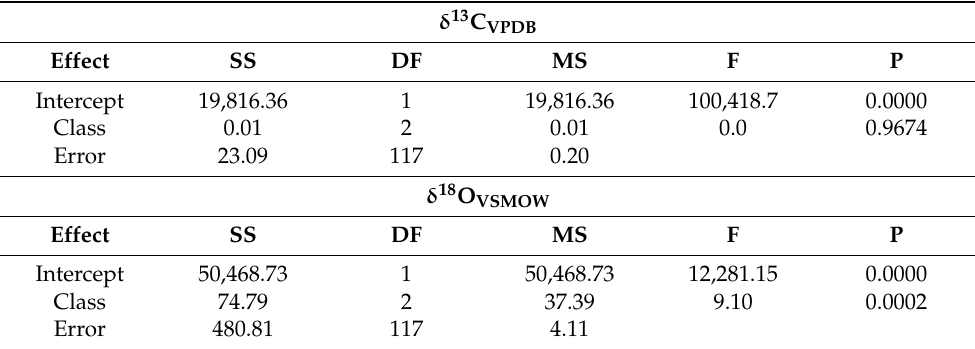
Table 1. One-way analysis of variance for δ 13 C VPDB and δ 18 O VSMOW in different classes of 100% agave tequila (silver, aged, and extra-aged class). SS: Sum-of-squares, DF: Degrees of freedom, MS: Mean squares, F: F-value = MS intercept /MS error , P: p -value.